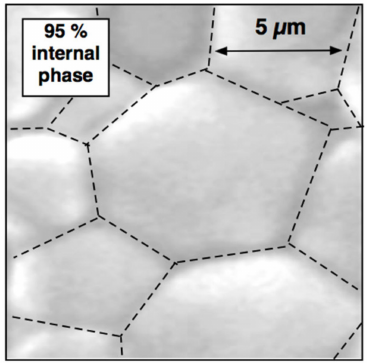
Figure 28. Typical aspect of compacted drops in a high internal phase W/O emulsion with a dispersed